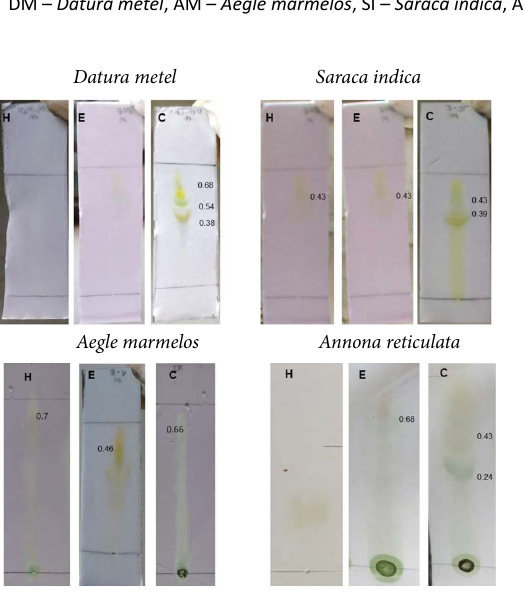
Fig. 3. TLC bioautography for antioxidant activity of medicinal plants chosen for this study. H – aqueous extract, E – ethanol extract, C- Chloroform extract